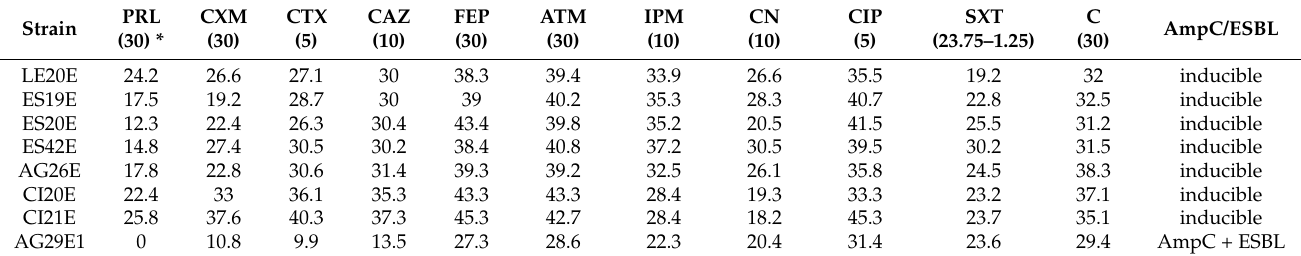
Antibiotics. PRL: Piperacillin; CXM: Cefuroxime; CTX: Cefotaxime; CAZ: Ceftazidime; FEP: Cefepime; ATM: Aztreonam; IPM: Imipenem; CN: Gentamicin; CIP: Ciprofloxacin; SXT: Sulfamethoxazole and trimethoprim; C: Chloramphenicol. *